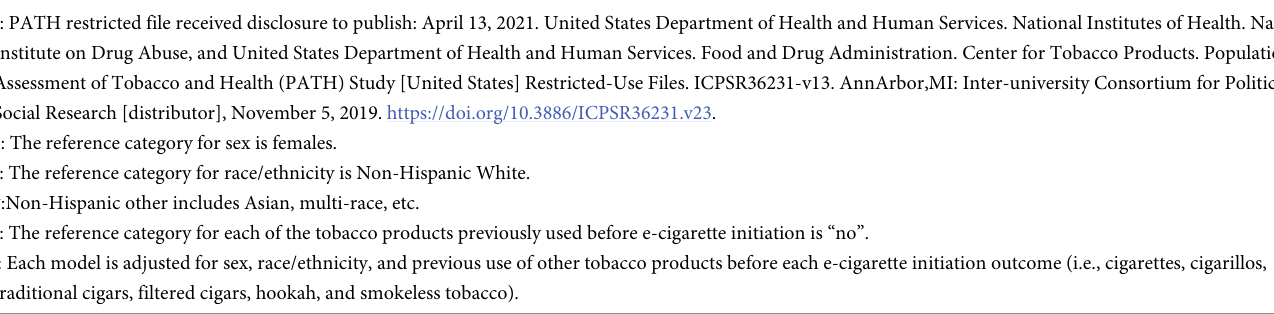
30-day e-cigarette initiation. Finally, when adjusting for sex and race/ethnicity, previous ever use of cigarettes and filtered cigars were associated with an increased risk for an earlier age of fairly regular e-cigarette initiation. The distributions of the age of initiation of e-cigarette out- comes stratified by sex and by race/ethnicity are presented in Table 4, and the full distribution of ages within a week’s precision are displayed in Figs 2 and 3. We found that by age 25, the upper limit of young adulthood, 36.8% of males and 31.1% of females were estimated to initiate ever e-cigarette use. The largest increases in initiation of ever e-cigarette use occurred between ages 18 and 19 for males and females (9.5% and 7.2%, respectively). By age 25, 16.7% of males and 12.8% of females were estimated to initiate past 30-day e-cigarette use. The largest increase in initiation of past 30-day e-cigarette use occurred between ages 21 and 22 (5.3%) for males and between ages 25 and 26 for females (4.5%). By age 25, 7.9% of males and 5.2% of females were estimated to initiate fairly regular e-cigarette use.